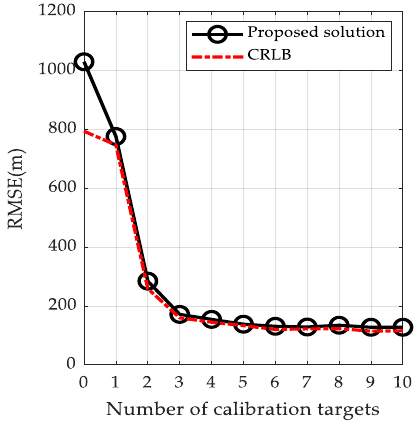
Figure 7. Localization accuracy versus the number of calibration targets.